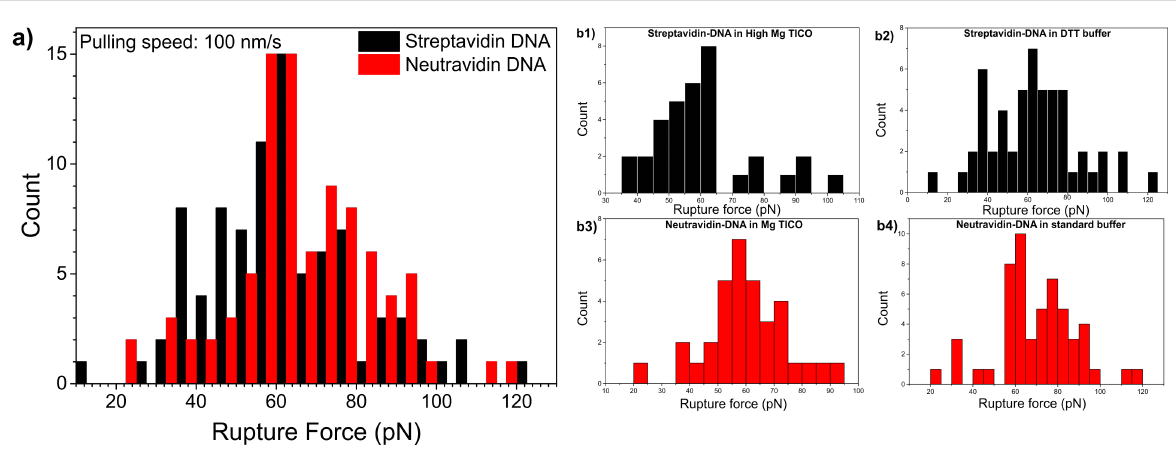
Figure 4: Selected force distributions for protein–DNA coupled to anti-DIG beads with the ratio 40:1. a) Combined rupture forces of streptavidin-DNA (b1 and b2) and neutravidin-DNA (b3 and b4) ( N = 176; 88 measurements per PDH, bin size 5). b1) Rupture forces of streptavidin-DNA in high Mg TICO (34 force measurements, bin size 5). b2) Distribution of rupture forces for streptavidin–DNA in DTT buffer (54 measurements, bin size 5). b3) Rupture forces of neutravidin–DNA in TICO (34 measurements, bin size 5). b4) Rupture forces of neutravidin–DNA in standard buffer (54 mea-